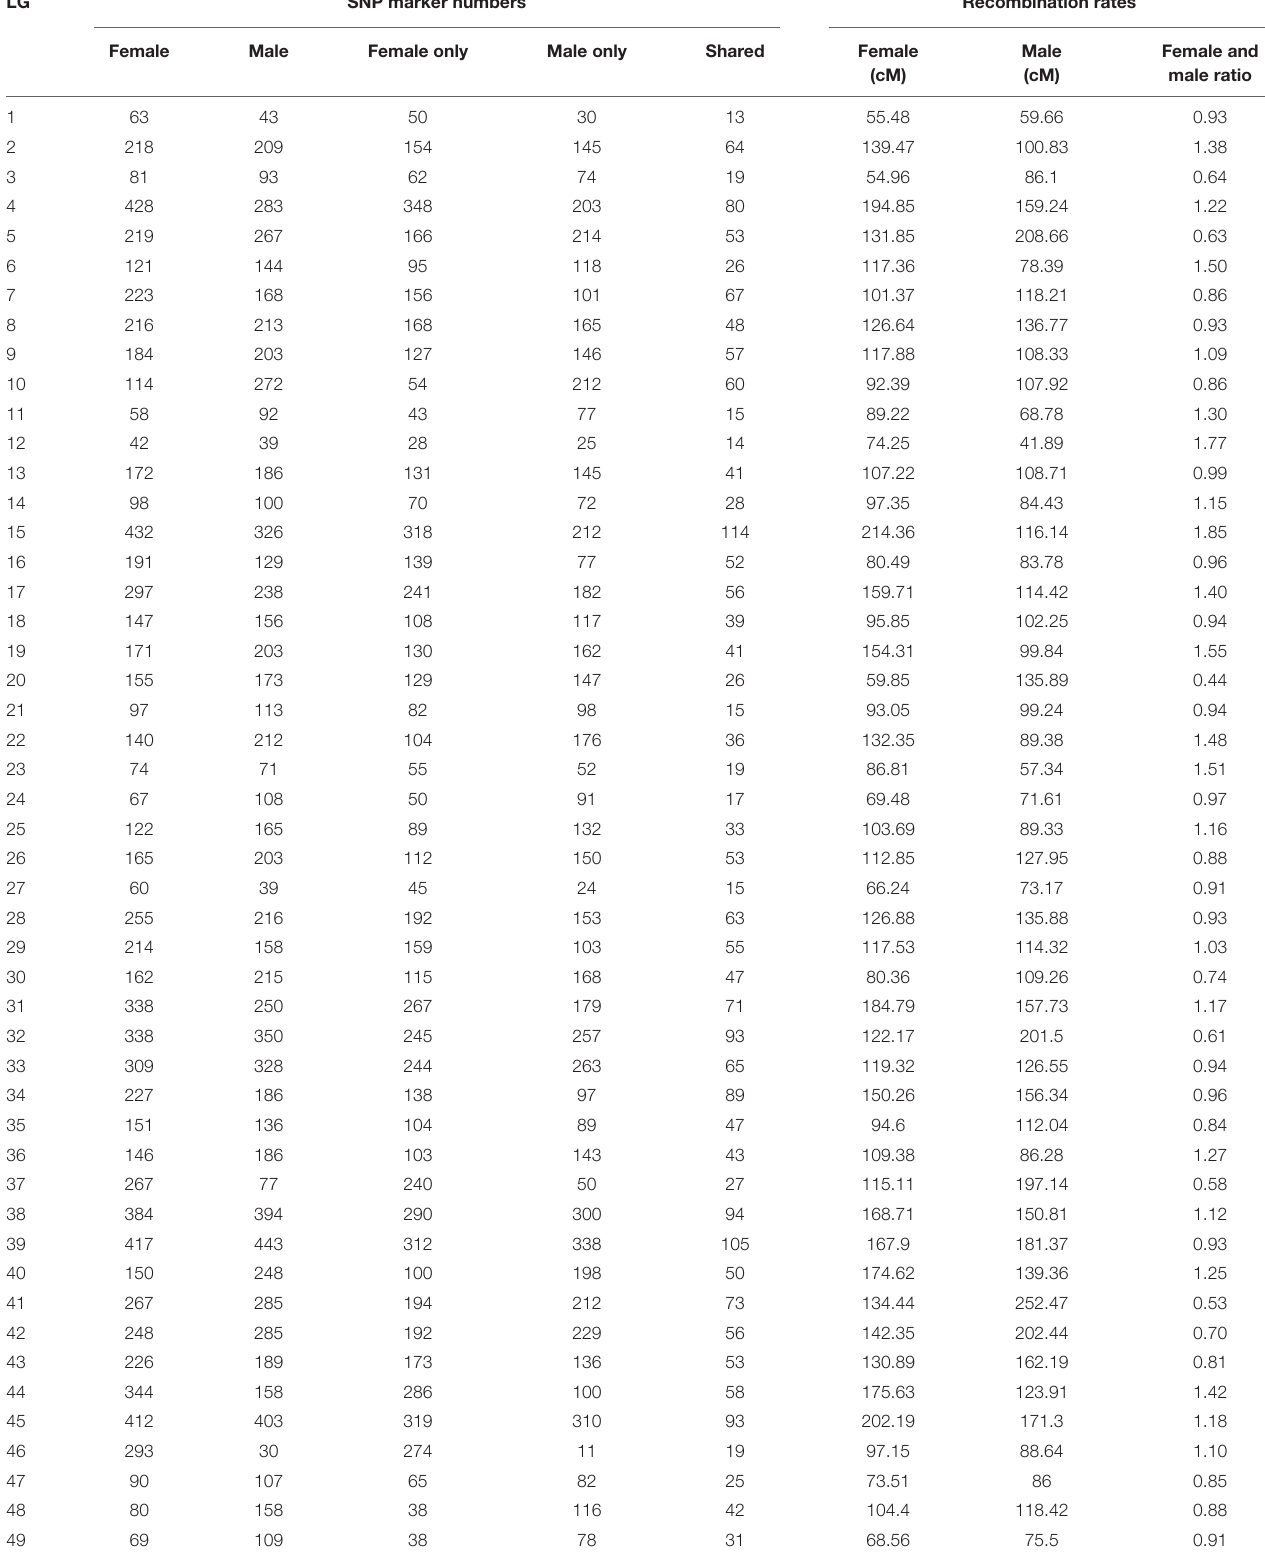
TABLE 5 | The SNP marker numbers and recombination rates (all markers) of each LG of Scylla paramamosain .